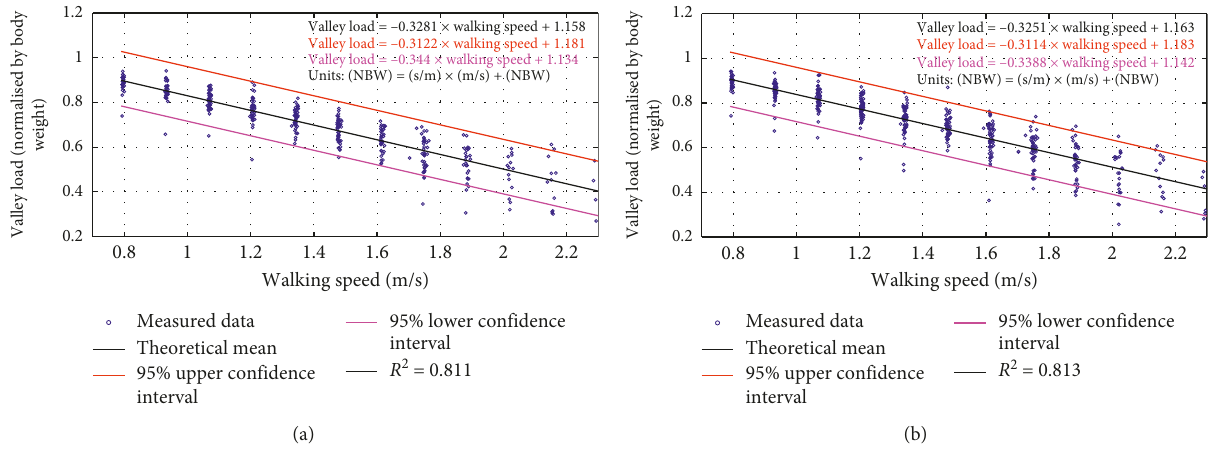
Figure 8: Statistical relationship between walking speed and valley load. (a) Right footfall; (b) left